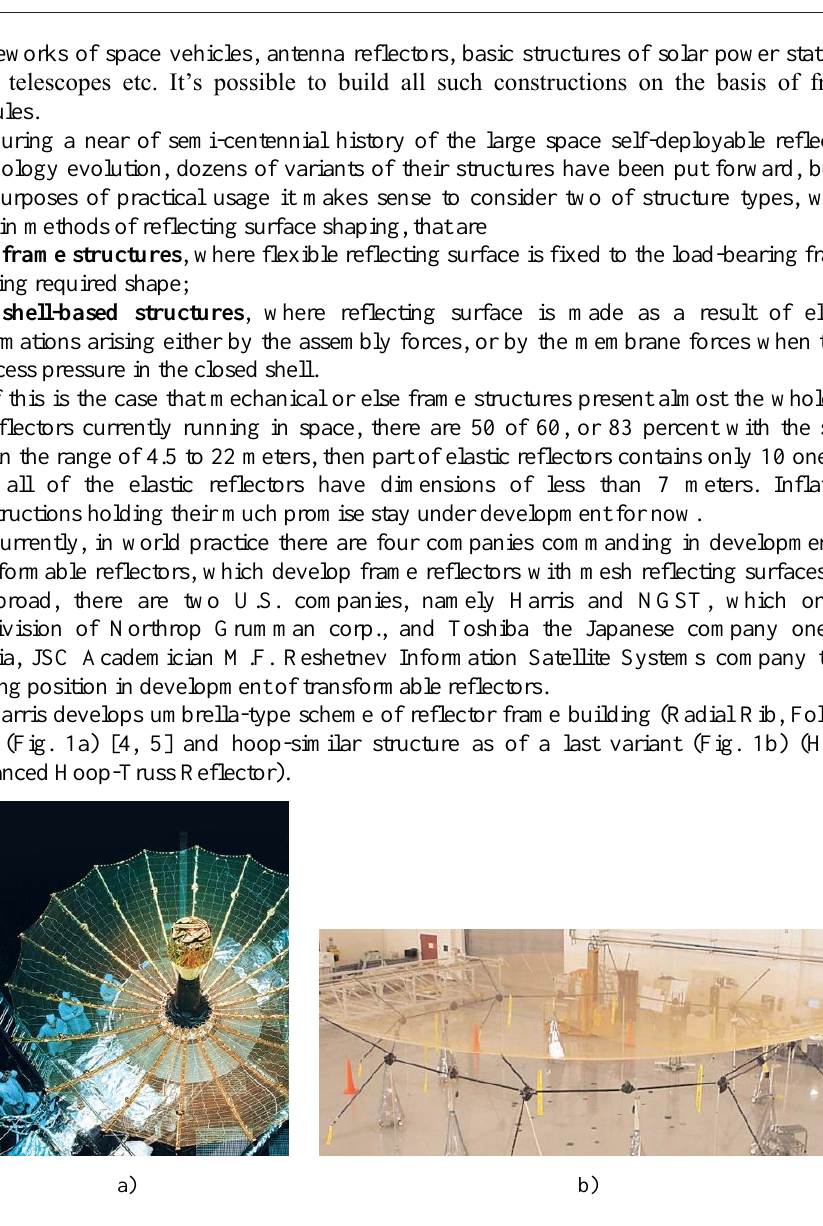
Fig. 1. Umbrella-type and hoop-type schemes of reflectors by